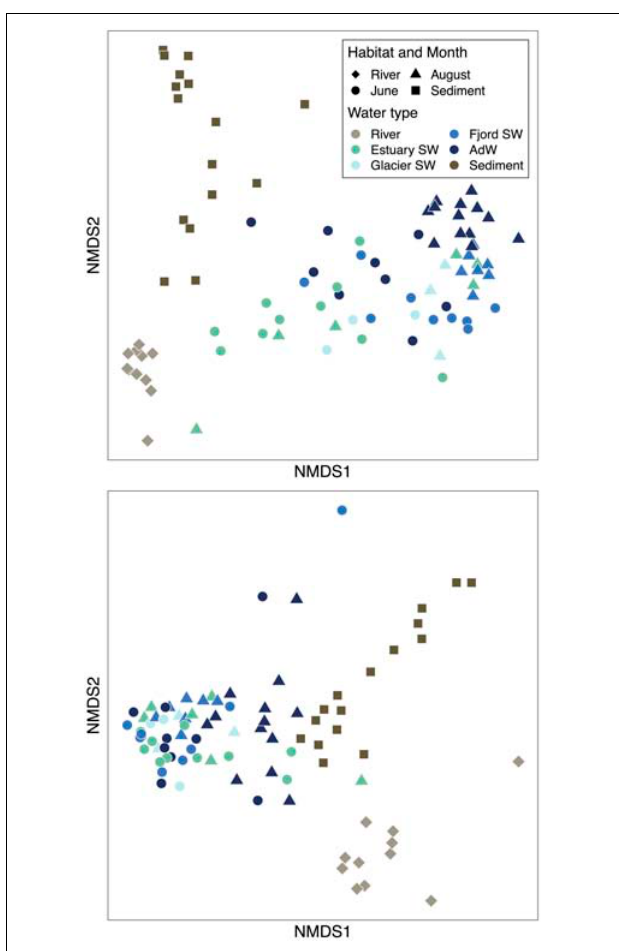
FIGURE 3 | Non-metric multidimensional scaling (NMDS) ordinations showing bacterial beta diversity based on Bray-Curtis dissimilarities of (A) microbial community structure in the fjord (stress value = 0.15) and (B) functional composition based on predictions of the KEGG metabolic pathways based on OTU data (stress value = 0.06). The same legend applies to the two